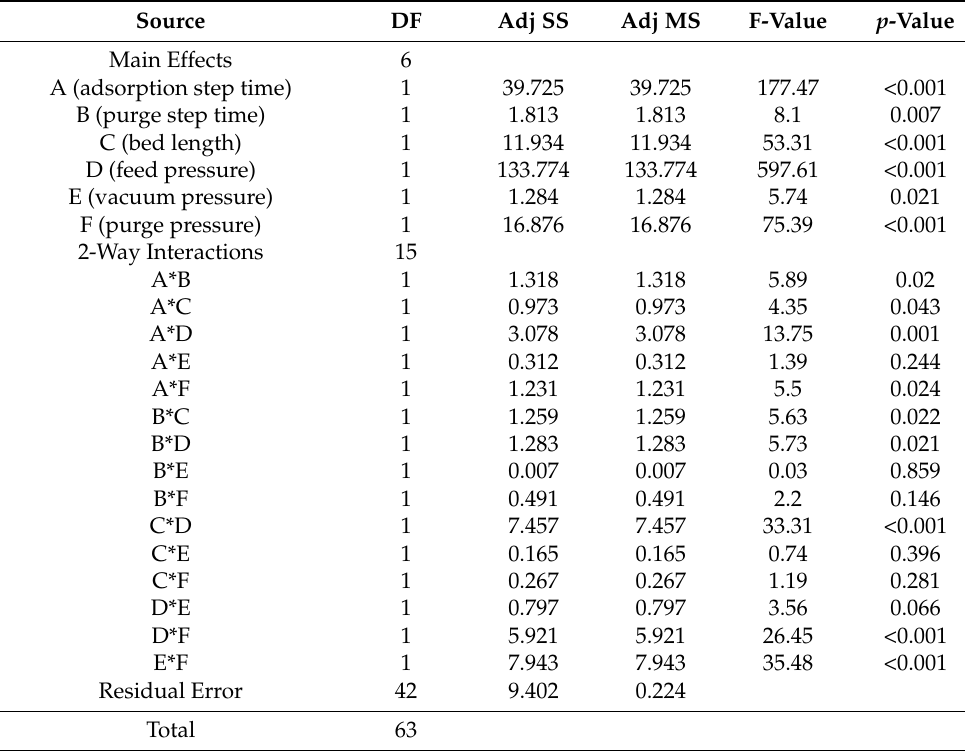
Table 15. The ANOVA table for the top product CH 4